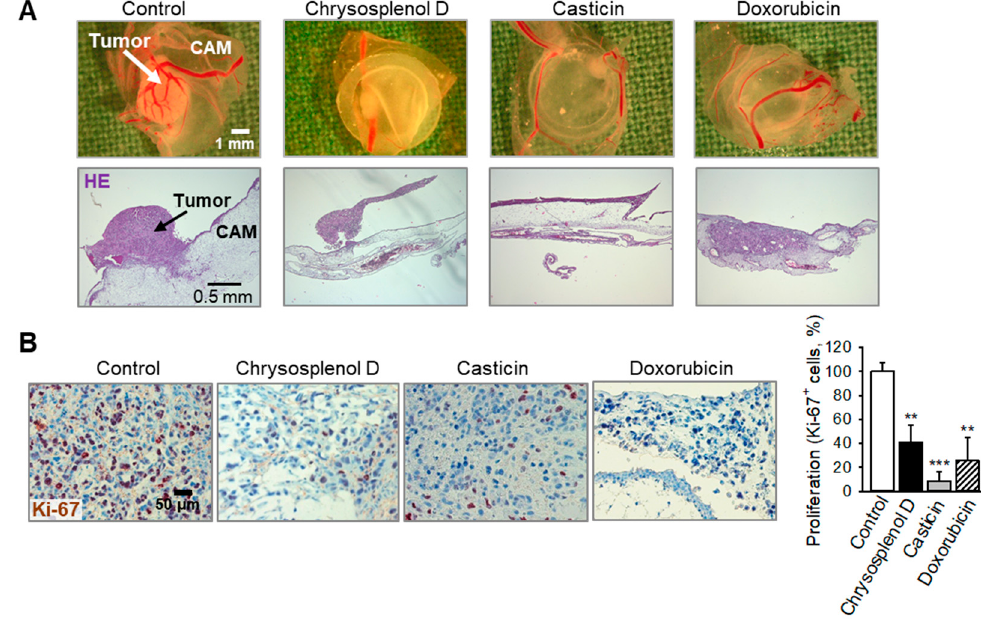
Figure 5. Chrysosplenol d and casticin inhibit proliferation of breast cancer xenografts in vivo. MDA-MB-231 xenografts grown on chick chorioallantoic membranes (CAM) were treated for 3 d with either chrysosplenol d , casticin (each at 30 µ M), or doxorubicin (1 µ M) as positive control. On day 4 after initiation of treatment, tumors were collected and analyzed immunohistochemically. ( A ) Representative pictures of tumor xenografts immediately after extraction (upper row) or hematoxylin and eosin (HE) staining (lower row, original magnification 50 × ). ( B ) Immunohistochemical staining of proliferating Ki-67 + cells (brown nuclear stain). Nuclei were counterstained with hematoxylin (blue). Original magnification 200 × . Graph shows reduction of proliferating Ki-67 + cells compared to controls. Data are mean ± SEM, n = 4–7, ** p < 0.01, *** p < 0.001 vs. controls.